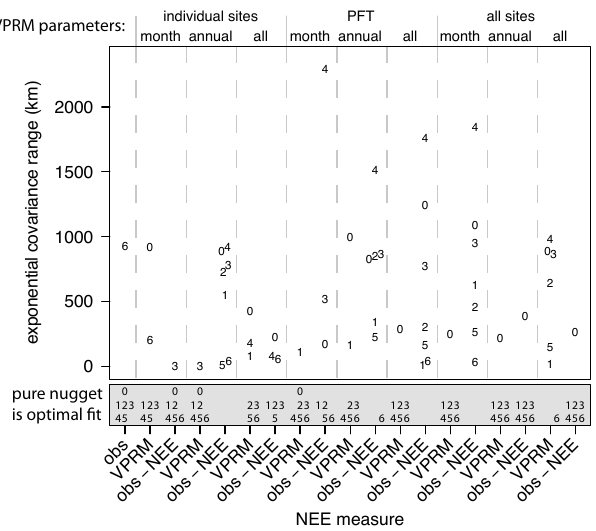
Fig.6. Best-fitrangevalues(km)forcumulativeannualanomaliesofobservedNEE,VPRMNEE,andVPRM Fig. 6. Best-fit range values (km) for cumulative annual anomalies NEE residuals. Best-fit values were determined by AIC as described in section 2.4. The number y plotted of observed NEE, VPRM NEE, and VPRM NEE residuals. Best- denotestheyear200 y . Yearswherethepurenuggetcovariancefunctionfitmoreoptimallythantheexponential fit values were determined by AIC as described in Sect. 2.4. The areshownintheshadedbox. Anomalieswerecalculatedasthedeparturefromthemeanvalueof2000to2006 number (0–6) plotted denotes the year (2000–2006). Years where annualmeancumulativeobservedvalues. the pure nugget covariance function fit more optimally than the ex- ponential are shown in the shaded box. Anomalies were calculated as the departure from the mean value of 2000 to 2006 annual mean cumulative observed